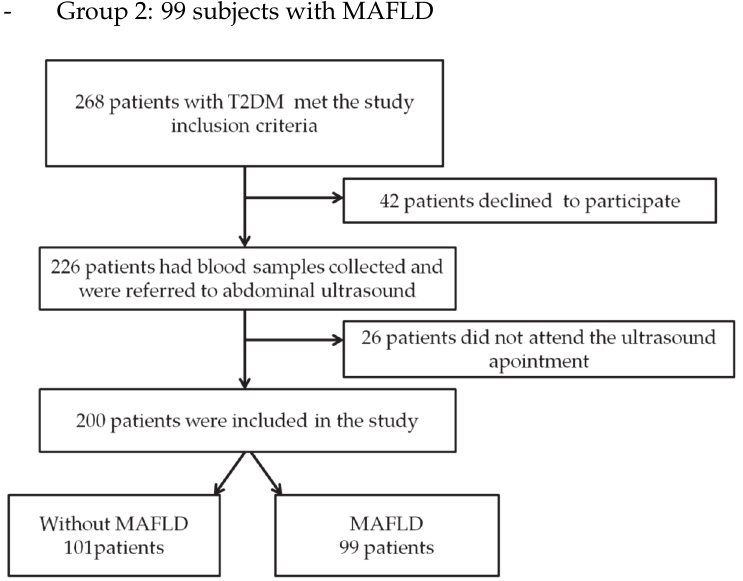
Figure 1. Study flow chart.